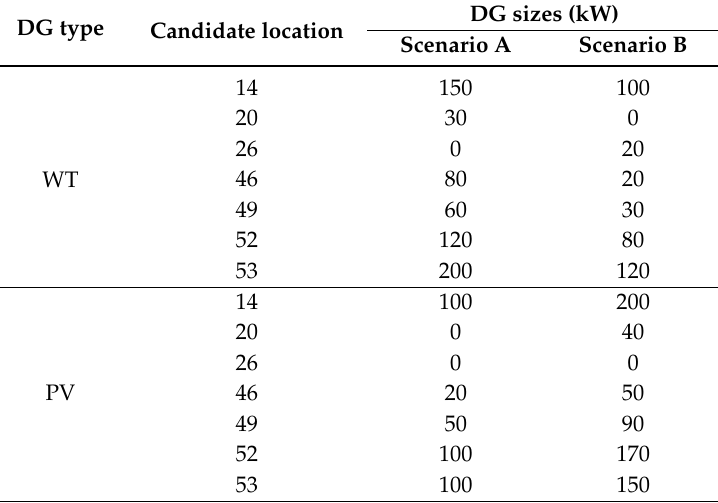
Table 8. Optimization results of different scenarios (69-bus